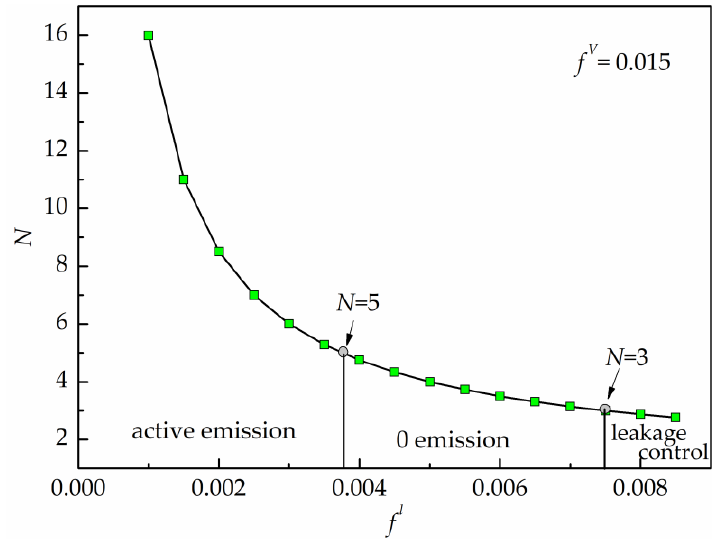
Figure 4 . The relationship between N and f l ( 𝑓 𝑃 = 0 ). Figure 4. The relationship between N and f l ( f P =